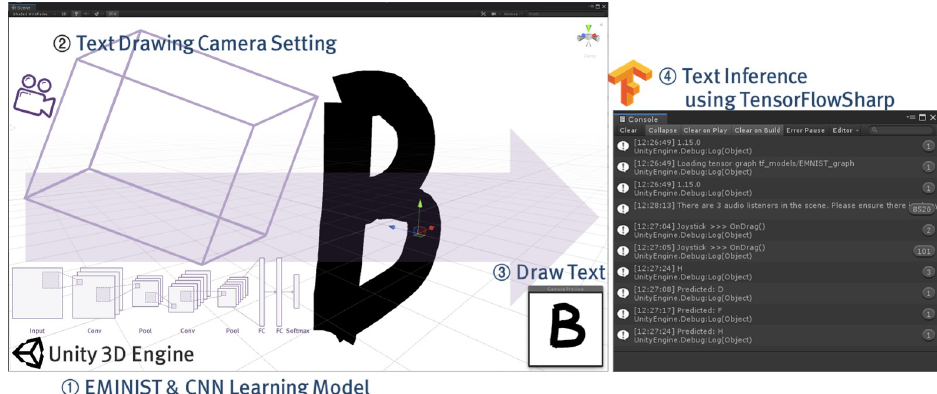
Figure 4. Recognition and processing process of handwritten text with the Unity3D